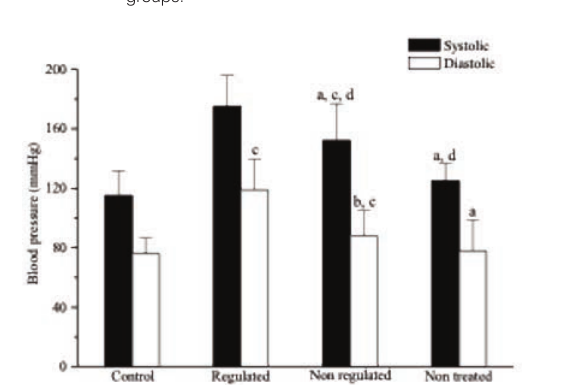
Figure 1. Systolic and diastolic blood pressure in investigated groups.